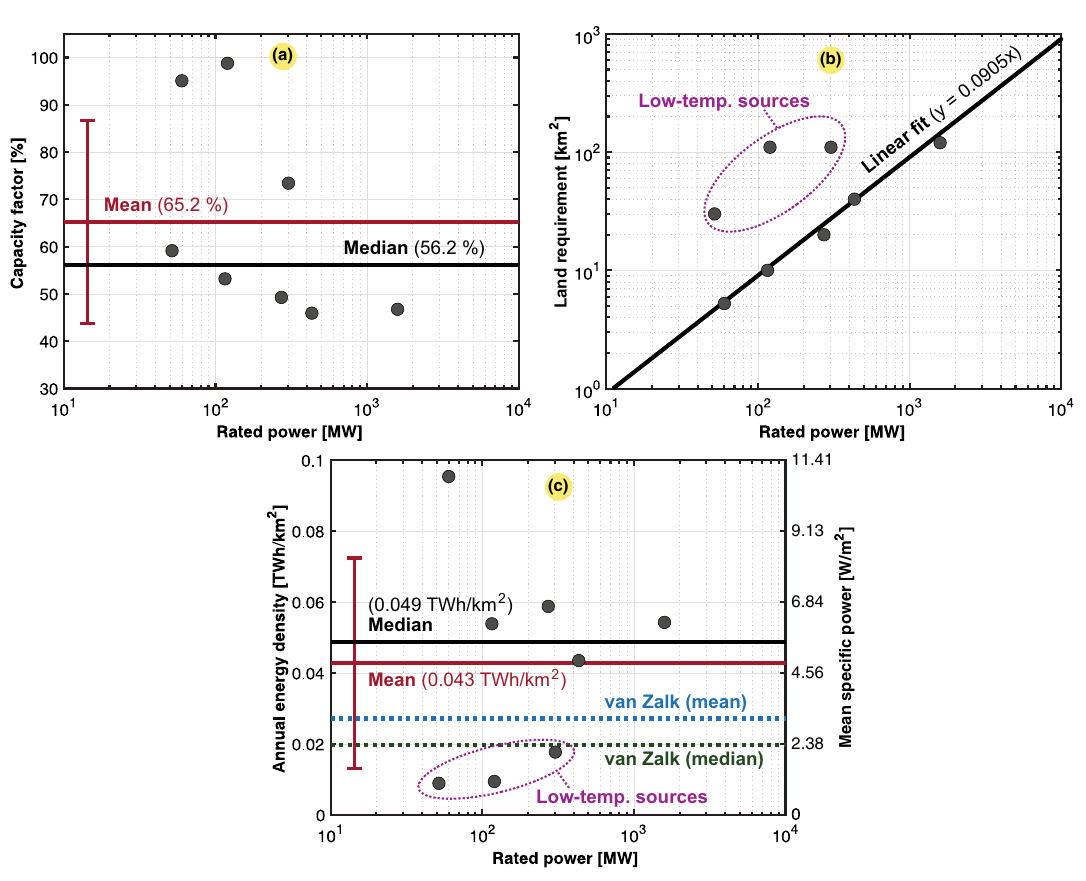
Figure 5. Case study of 8 geothermal power plants, 3 in Iceland and 5 in the United States. Typical, mean, median, and fitted values are also included. ( a ) Capacity factor ( C g ). ( b ) Land use ( A g ). ( c ) Annual energy density ( ε g ) or mean specific power ( p g ) with van Zalk and Behrens 3 as a